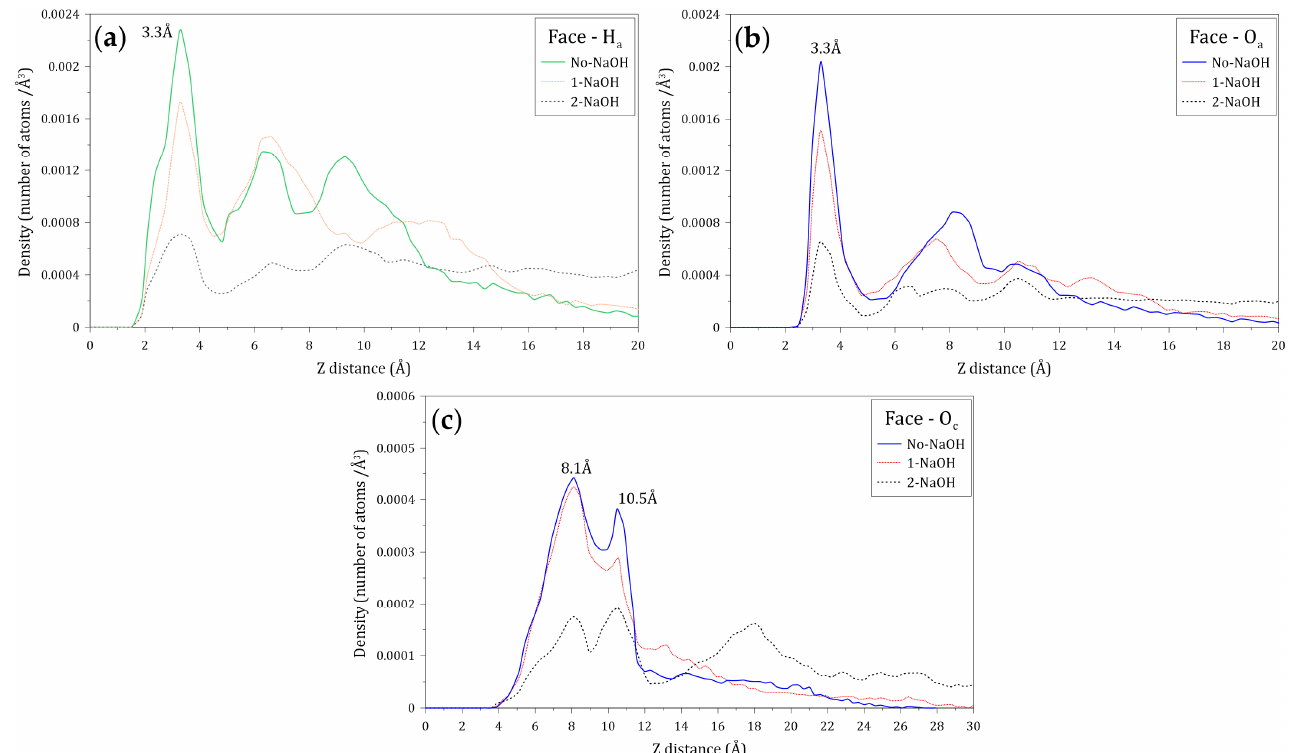
Figure 10. Density profiles of the ( a ) hydrogen atoms of amide groups (H a ), ( b ) oxygen atoms of amide groups (O a ), and ( c ) oxygen atoms of carboxylate groups (O c ) located along the Z axis normal to the molybdenite face. These calculations were conducted at different concentrations of NaOH.